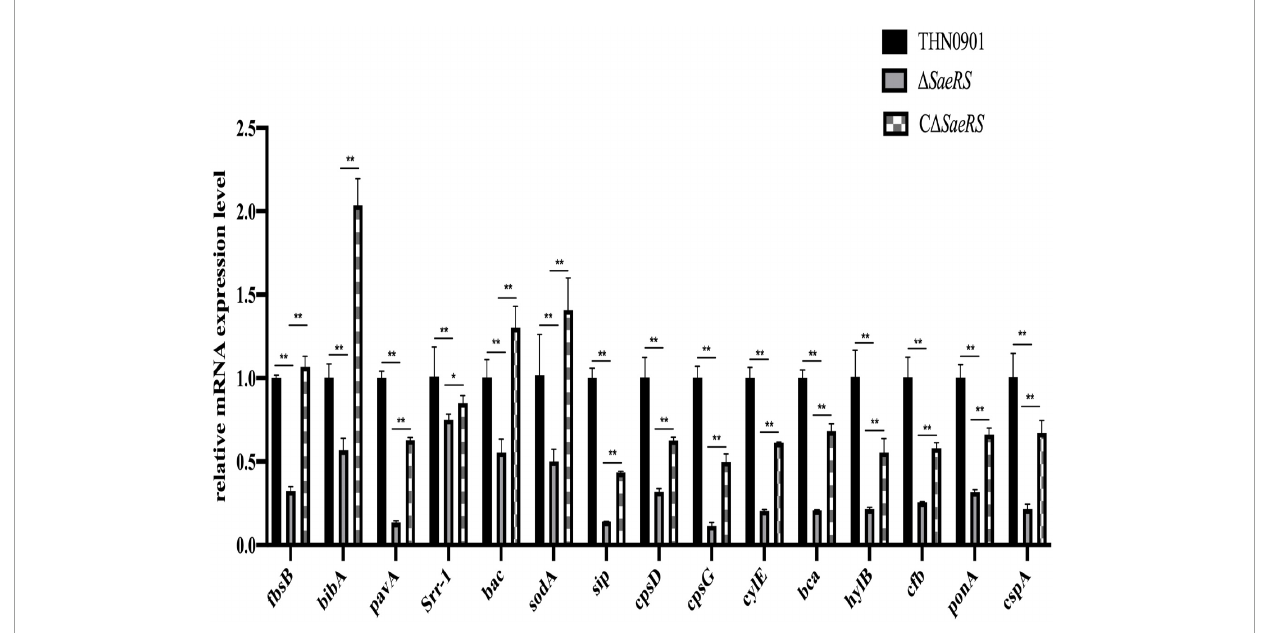
FIGURE7 Relative messenger RNA (mRNA) expression level of virulence factors of S. agalactiae among three strains. Each experiment was performed in triplicate, and data were presented as mean ± standard deviation (SD), *: 0.01 < P < 0.05, **: P <